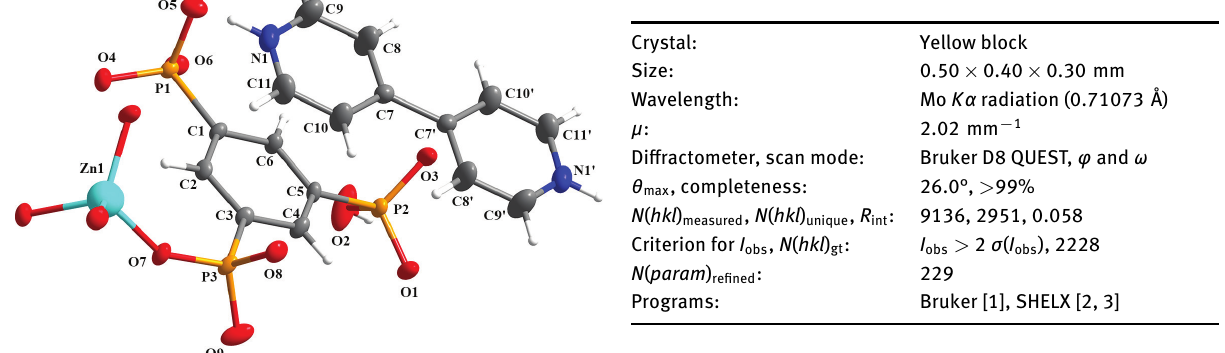
Table 1: Data collection and handling.